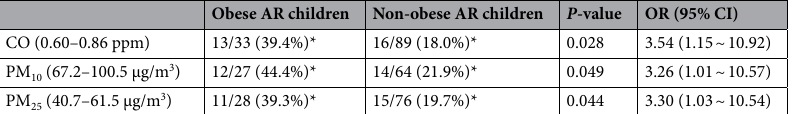
Obese AR children Non-obese AR children P -value OR (95% CI) CO (0.60–0.86